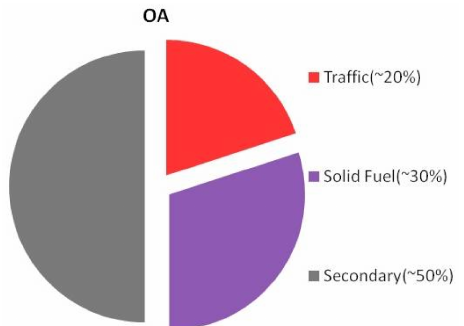
Figure 1. Fractional contributions of three major components of ambient organic aerosols (OAs) observed at IITDelhi (during 16 January–11 March